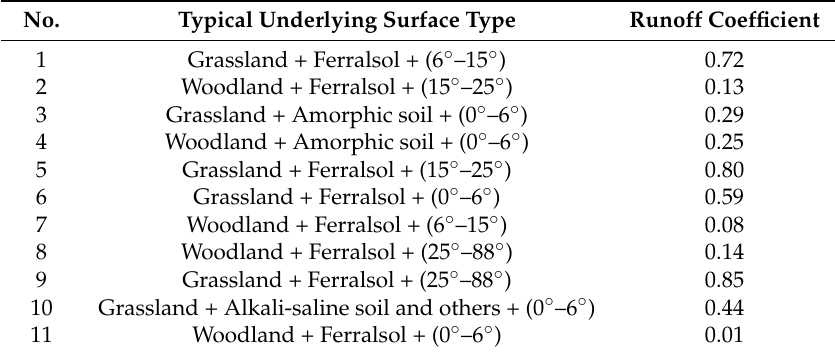
Table 2. Runoff coefficients of typical underlying surfaces based on field experiments.